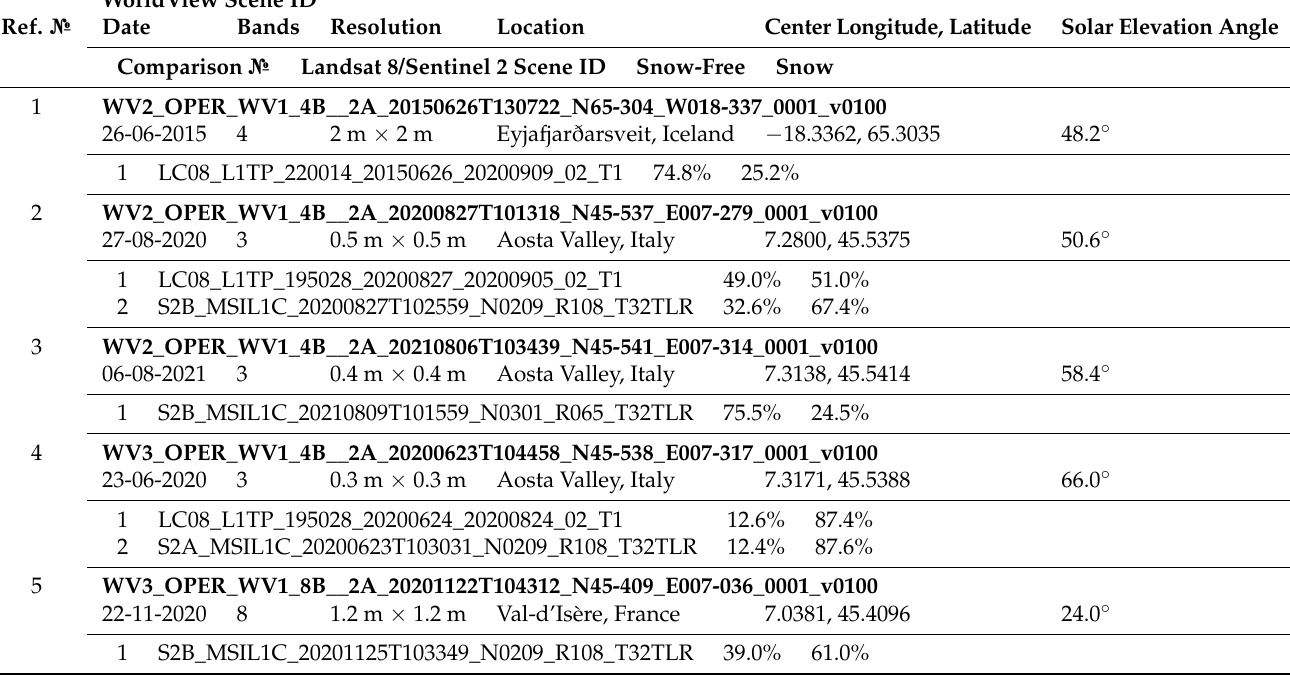
Table A2. List of WorldView data that were used for validation of the LAMSU method.